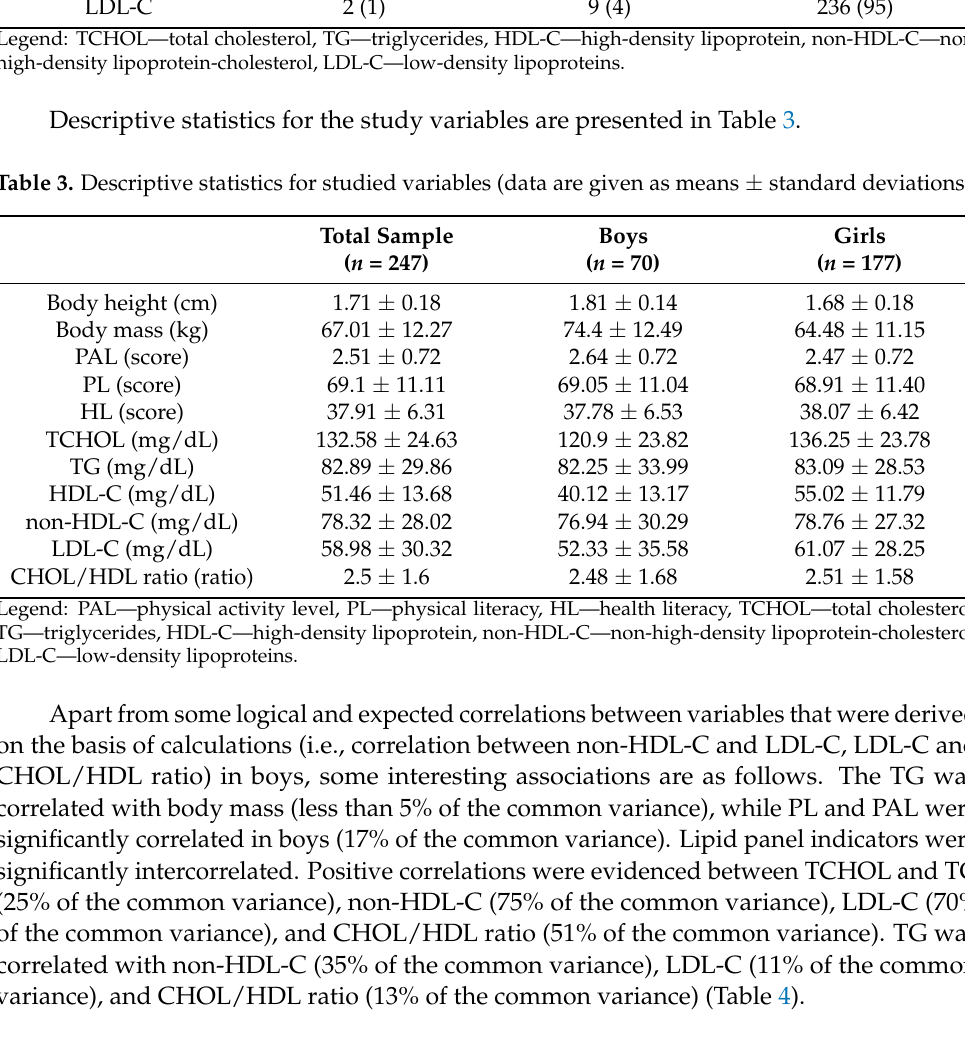
Table 4. Correlations between studied variables for boys ( n =